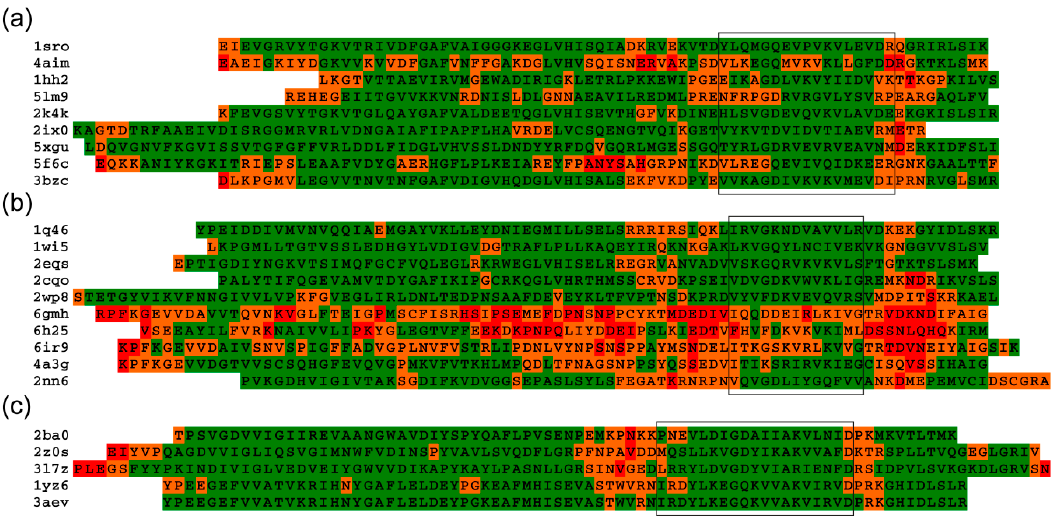
Figure 4. Sequences are structurally aligned relative to the framed segmented part of the S1 domains. S1 domains from ( a ) Bacteria, ( b ) Eukaryotes, and ( c ) Archaea. The colors of amino acid residues correspond to the degree of flexibility of tertiary structures according to the FlexPred software [41]: flexible (red, more than 6 Å), moderately flexible (orange, 3-6 Å), and rigid (green, less than 3Å) based on their respective values.